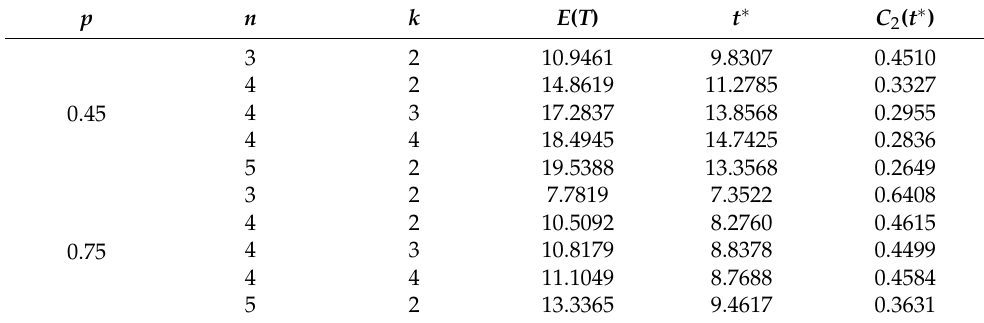
Table 5. Optimal solution with different parameters when c p = 2.5, c f = 5.5, λ = 0.55, δ = 2, m 1 = 1.